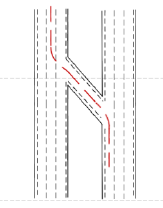
Figure 12. Schematic diagram of the S ramp.